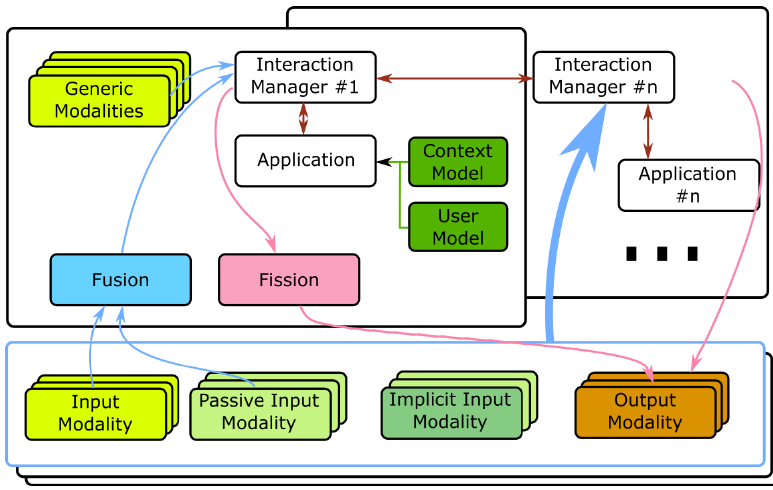
Figure 1. Proposed architecture: the core modules (e.g., interaction managers and applications) manage multiple modalities spread across different